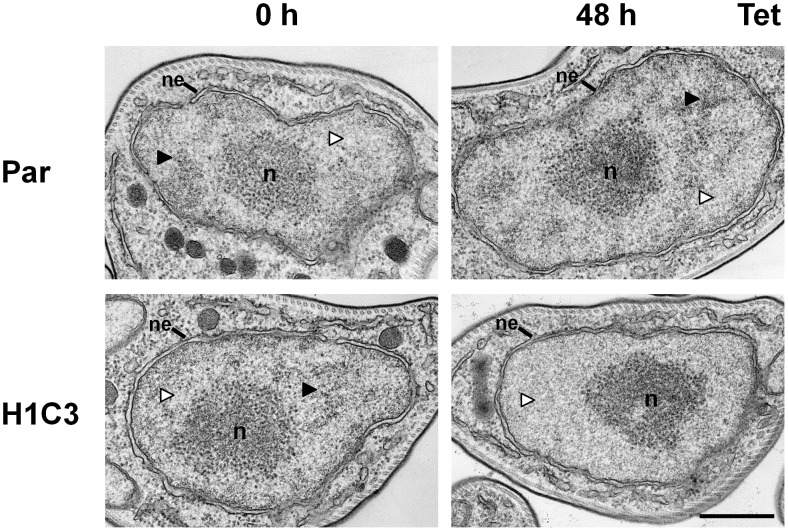
Alteration of nuclear ultrastructure in bloodstream form T. brucei after depletion of histone H1.The bloodstream form T. brucei RYT3BSR parental (Par) and the RYT3-H1C3 histone H1 RNAi cell line (H1C3) were cultured in the presence (48 h) or absence (0 h) of tetracycline (Tet) and analysed using transmission electron microscopy (TEM). Images show representative sections of nuclei that include the nucleolus (n) and the nuclear envelope (ne). The nuclei of parental T. brucei or RYT3-H1C3 lines before the induction of histone H1 RNAi have normal nuclear staining, where the nucleoplasm is divided into domains of greater electron density (black arrowheads), presumably corresponding to heterochromatin, interspersed with areas of lower density (white arrowheads), presumably corresponding to euchromatin. The nuclei of cells after the induction of histone H1 RNAi for 48 hours lack the dense chromatin domains. The scale bar represents 500 nm.